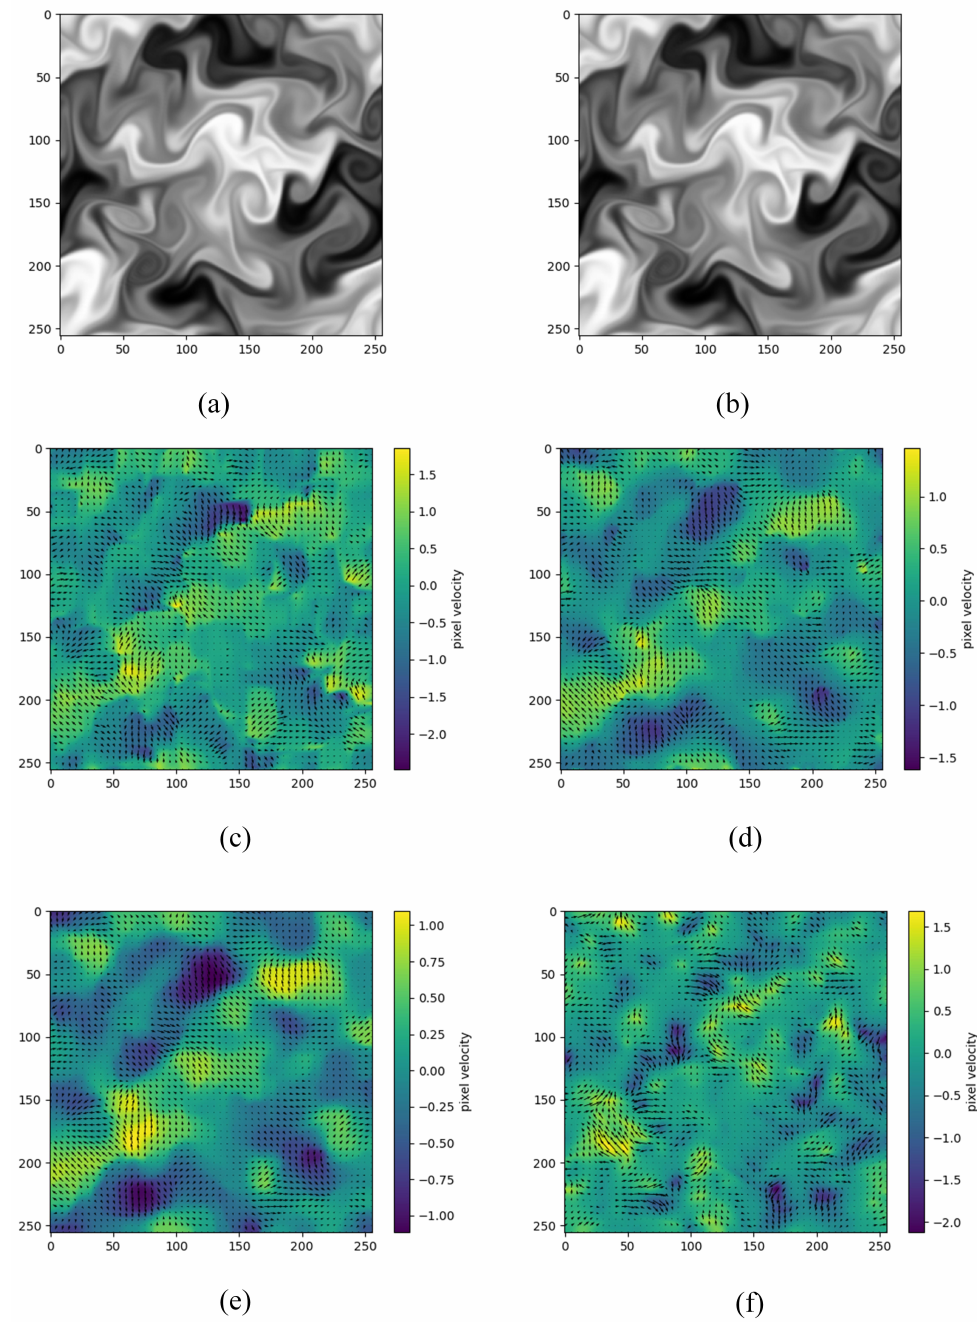
Figure 2. Scalar images and their velocity fields: ( a , b ) scalar image adjacent to two frames; ( c ) FB ( t = 60 ) ; ( d ) TV-L1 ( t = 60 ) ; ( e ) DIS ( t = 60 ) ; ( f ) SGS-HS ( t = 60 )